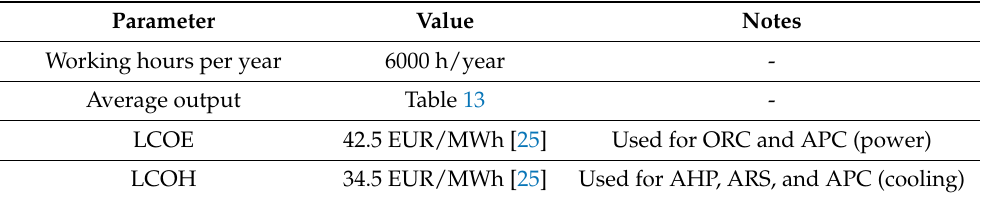
Table 14. Summary of the key parameters for the estimation of annual savings that each CHP technology could provide.